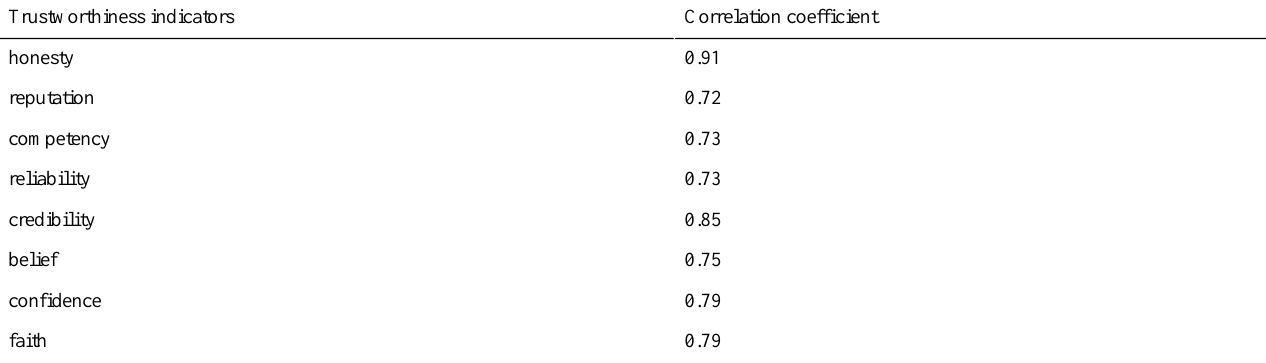
Correlation coefficientTrustworthiness